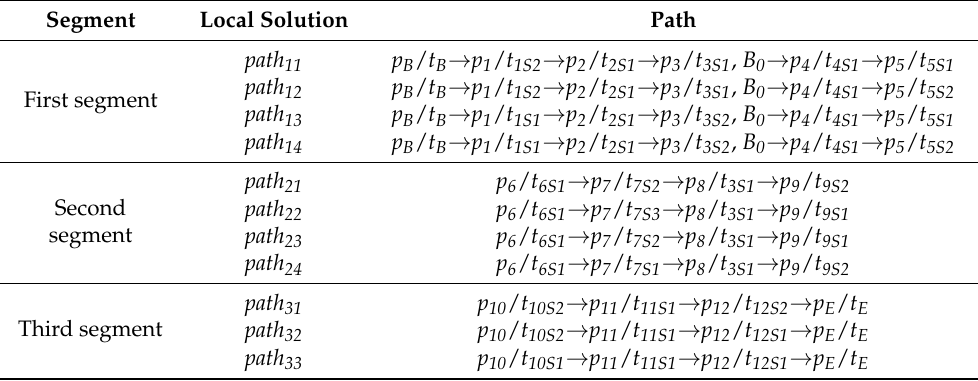
Table 6. Local feasible solutions for each optimization section.